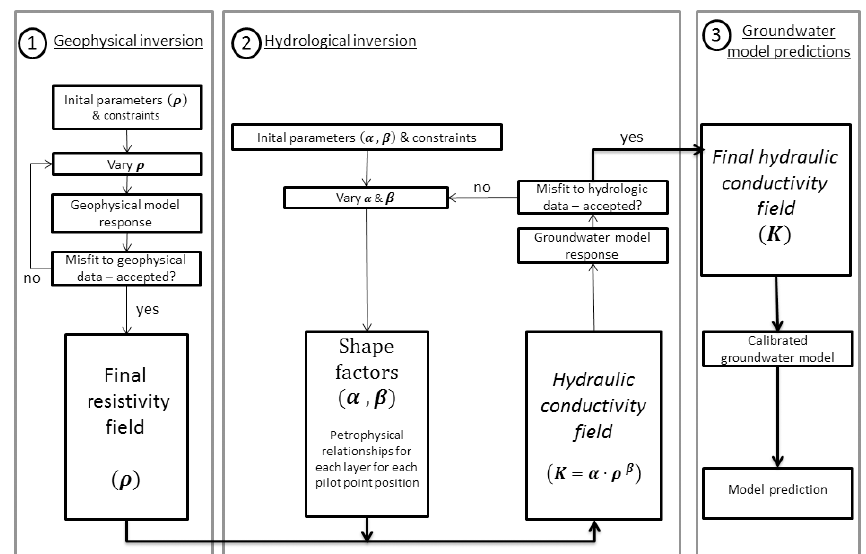
Figure 1. Conceptual flowchart for the sequential hydrogeophysical inversion. First step (box 1): geophysical inversion. Second step (box 2): groundwater model calibration where shape factors of the petrophysical relationship are estimated using hydrological data. Third step (box 3): the calibrated groundwater model is used for predictive